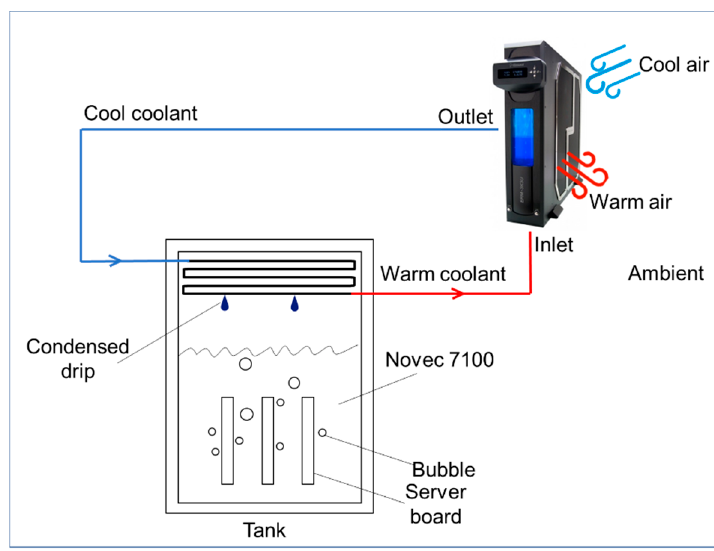
Figure 1. Scheme of the proposed cooling system.